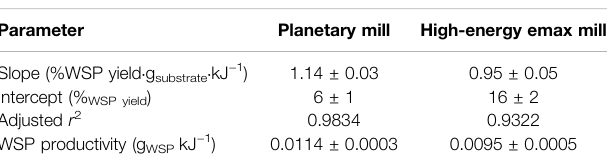
TABLE 2 | Linear regression parameters derived from the MCD datasets for the experimentscarriedoutintheplanetaryandhigh-energyEmaxmill,presented in Figure 3 .